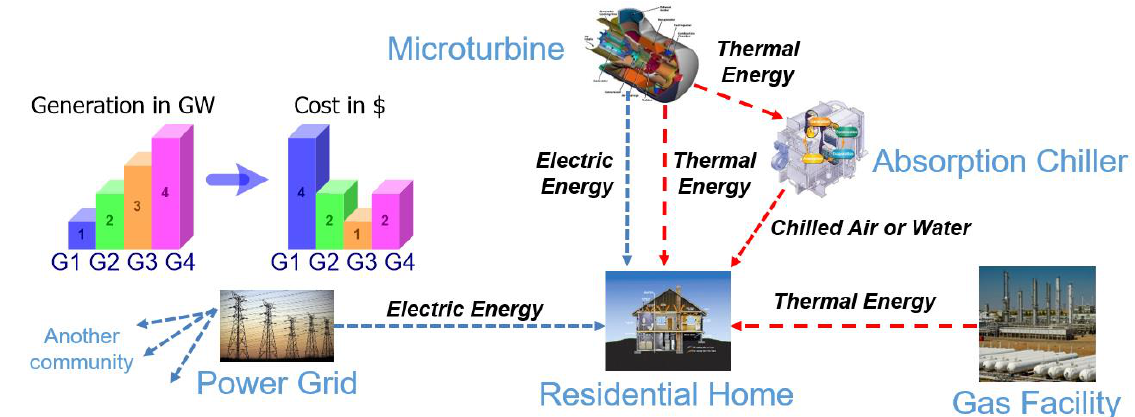
Figure 1. Residential home example including CCHP systems.